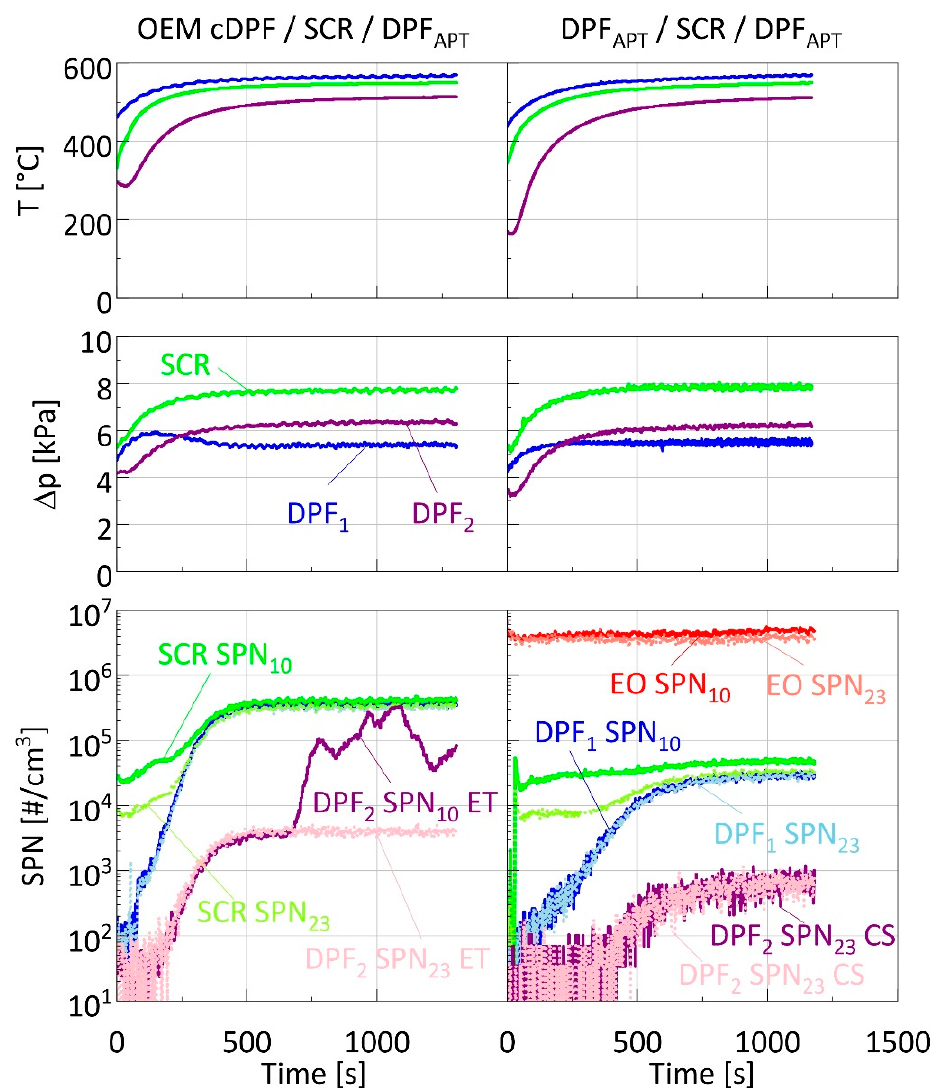
Figure 10. Temperatures (top panel), pressure drops (middle panel) and SPN concentrations (bottom panel) over two passive regeneration measurements with the OEM cDPF (left-hand panels) and DPF APT (right-hand panel). In the tests with the OEM cDPF, the ET system was employed for the measurements of SPN downstream of the DPF 2 . cDPF = Catalyzed DPF; CS = Catalytic Stripper; DPF = Diesel Particulate Filter; EO = Engine Out; ET = Evaporation Tube; OEM = Original Equipment Manufacturer; SPN = Solid Particle Number.